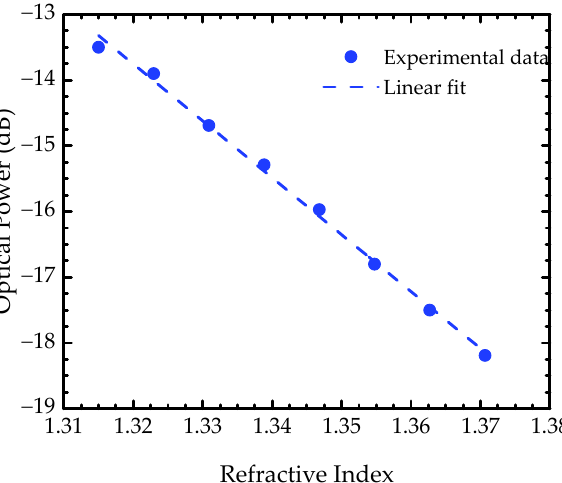
Figure 5. Experimental results of the optical power response to the correspondent refractive indices. The blue circles are the obtained data and the dashed blue line the applied linear fit.